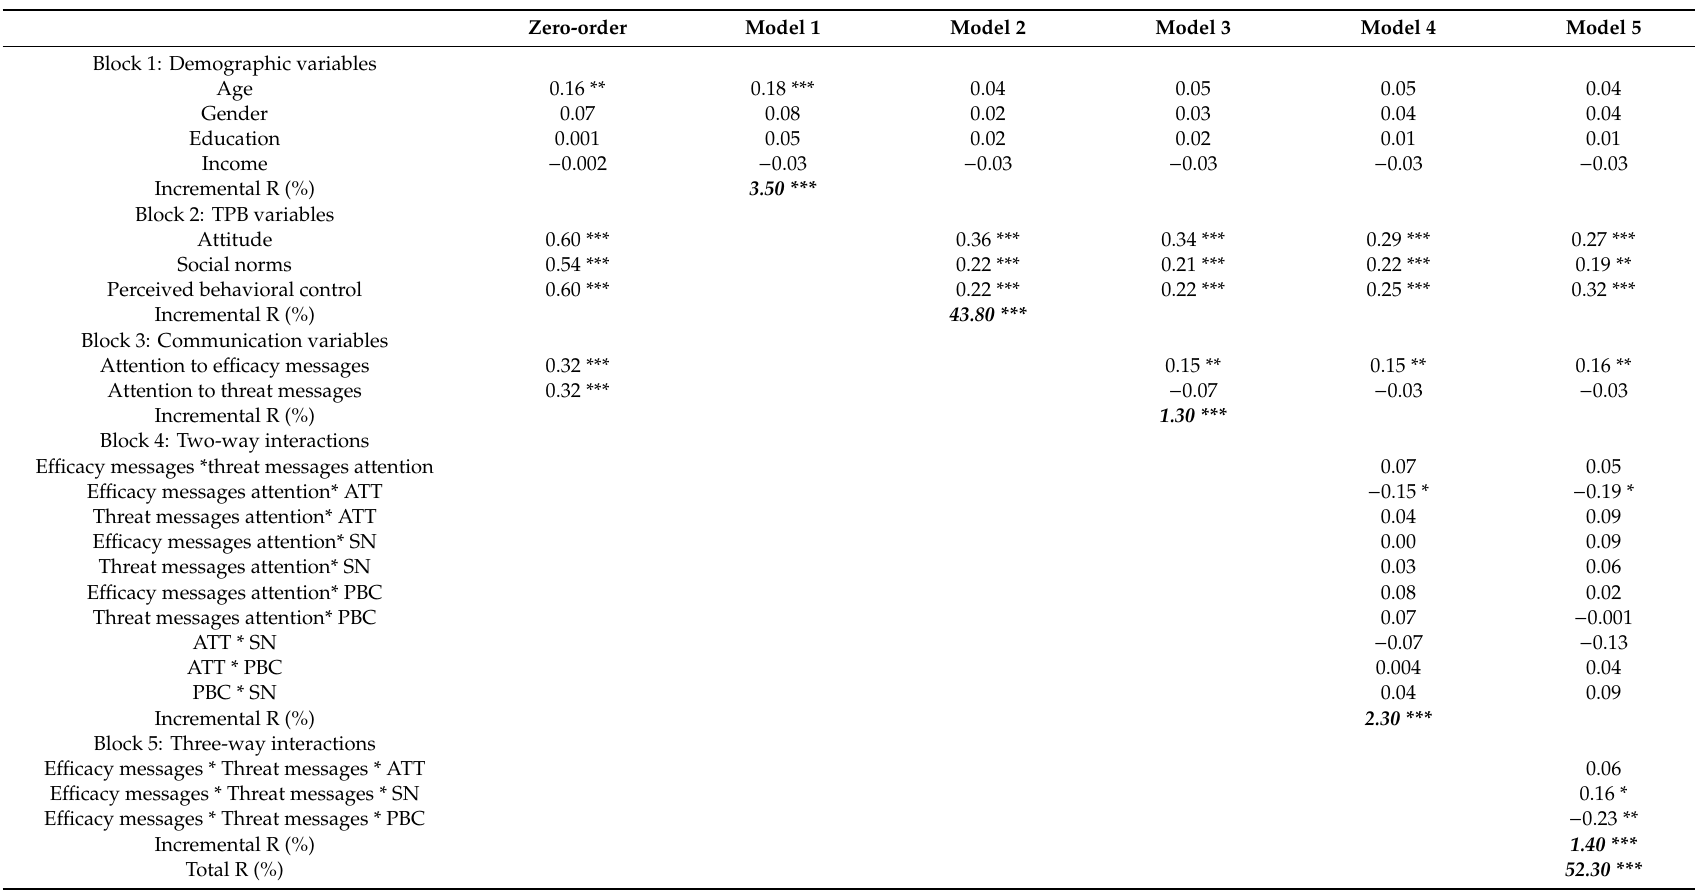
Table 2. Hierarchical regression analysis predicting pro-environmental behavioral